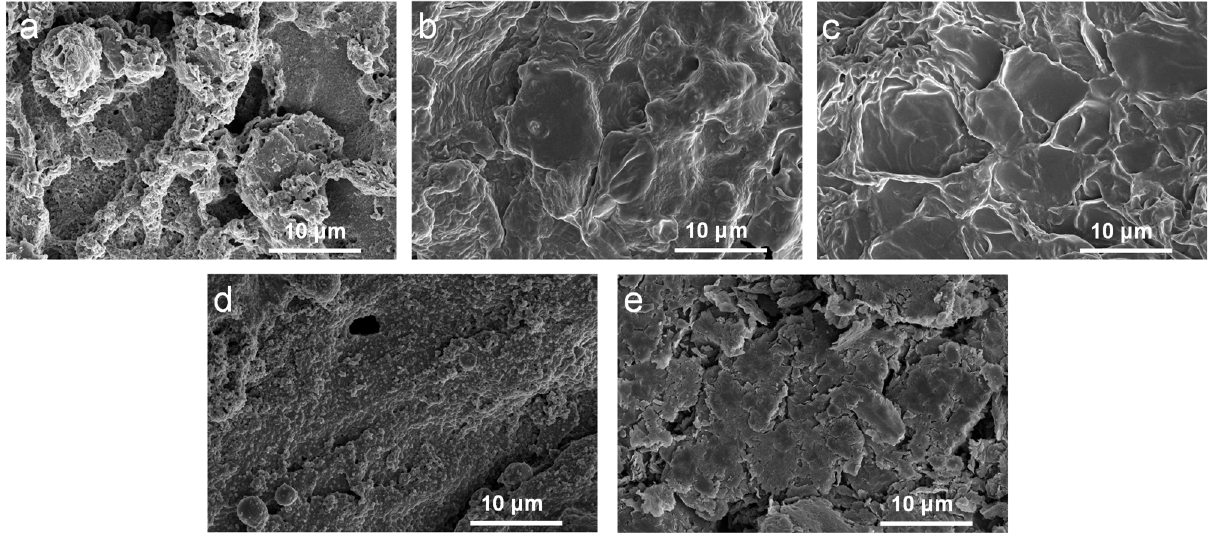
Figure 4. SEM images of the char residues of ( a ) PEG/WF/6.0APP@4.0OMMT, ( b ) PEG/WF/8.0APP@2.0OMMT, ( c ) PEG/WF/9.0APP@1.0OMMT, ( d ) PEG/WF/10.0APP and ( e ) PEG/WF/10.0OMMT composites after cone test.